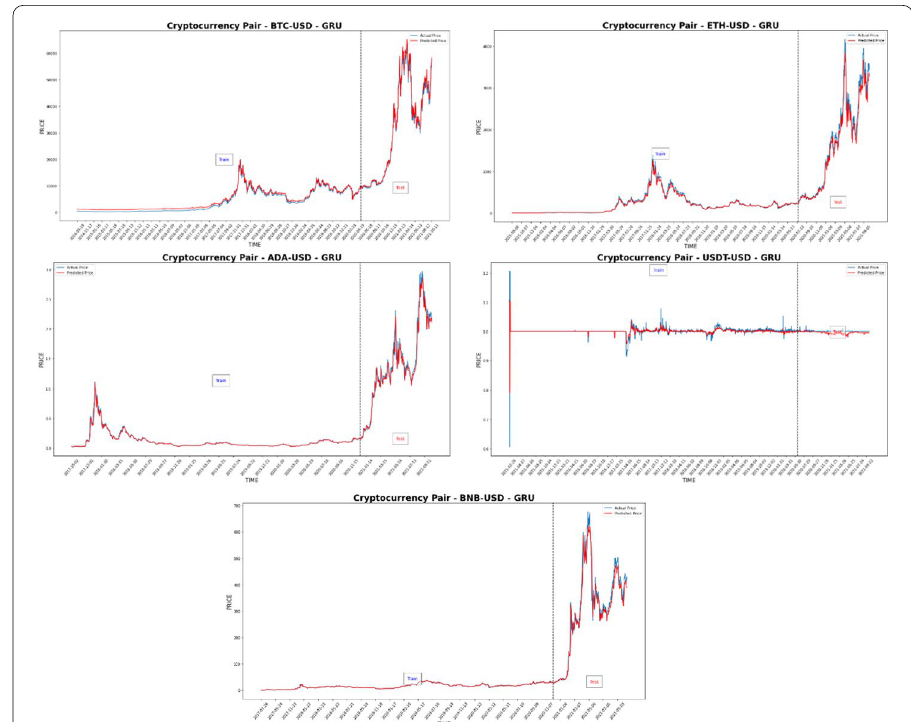
Fig. 7 Prediction results for five cryptocurrencies using